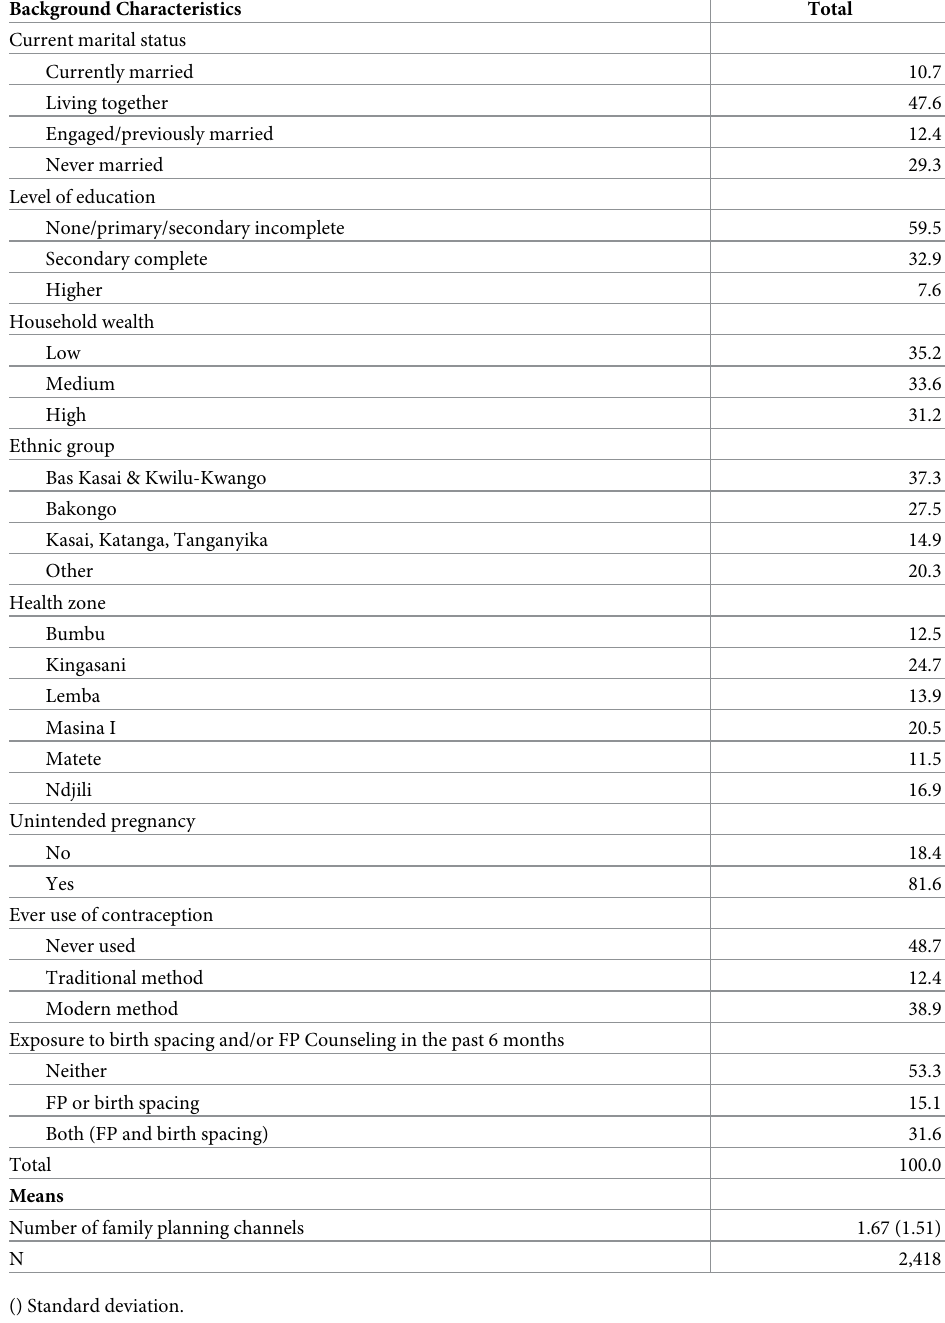
Table 1. Distribution of first-time mothers age 15–24 by background characteristics, Kinshasa 2018. Background